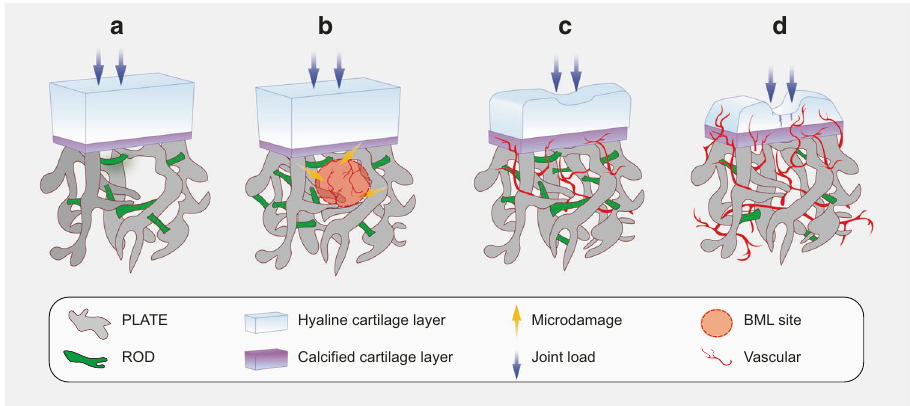
Fig. 2 Subchondral bone microstructural transformation during OA progression. Rod-like and plate-like trabeculae are distributed accurately at a proper ratio to disperse stress. Osteogenesis coupled with angiogenesis lead to an increased BMD and conspicuous microstructural changes at the subchondral level. A decrease in the rod/plate ratio and subchondral bone plate thickening result in excessive mechanical support, which is detrimental to chondrocyte metabolism. Vessel-induced digestion of the cartilage matrix from the bottom up also takes part in the progression of cartilage destruction. a Normal state; b early stage with BML and vascularization; c progressive stage with cartilage damage; d end stage with severe cartilage destruction and vessel